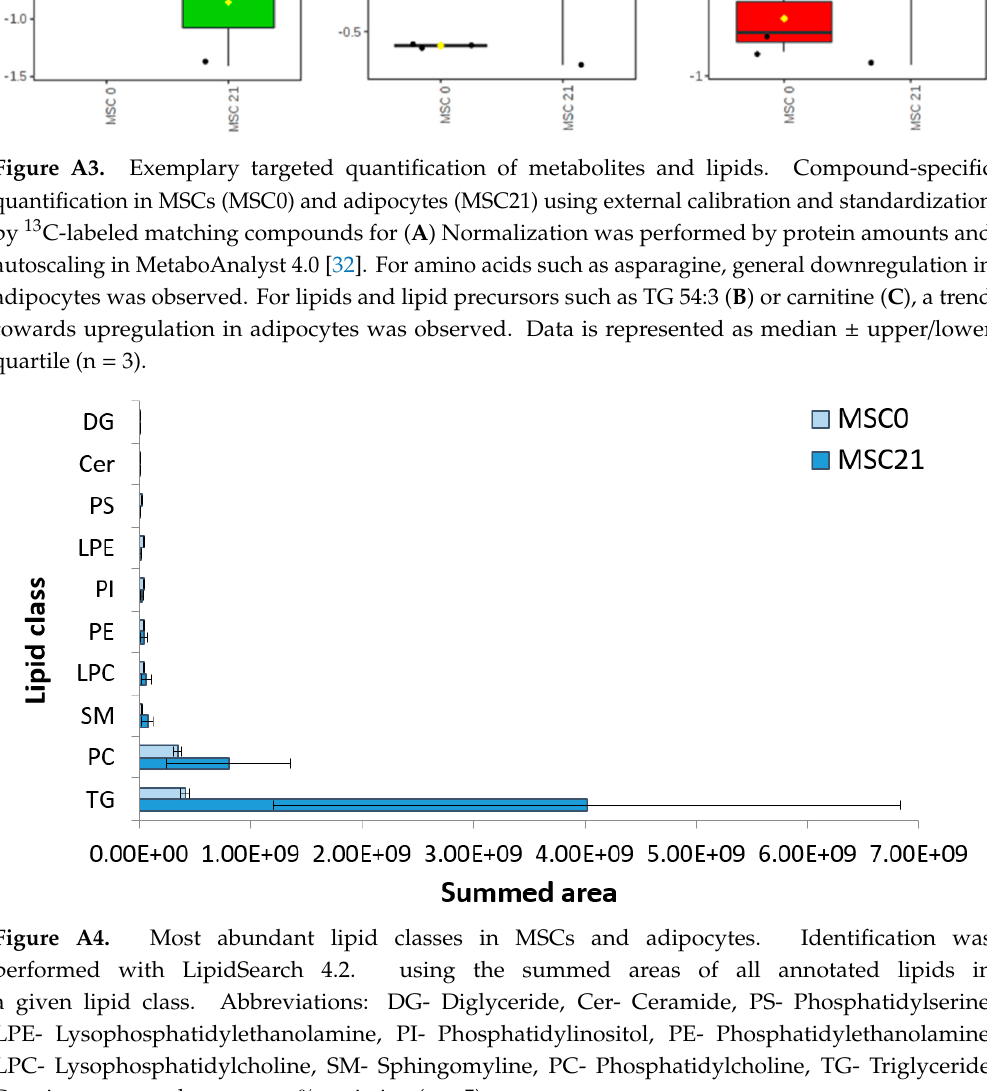
Figure A3. Exemplary targeted quantification of metabolites and lipids. Compound-specific quantification in MSCs (MSC0) and adipocytes (MSC21) using external calibration and standardization by 13 C-labeled matching compounds for A . Normalization was performed by protein